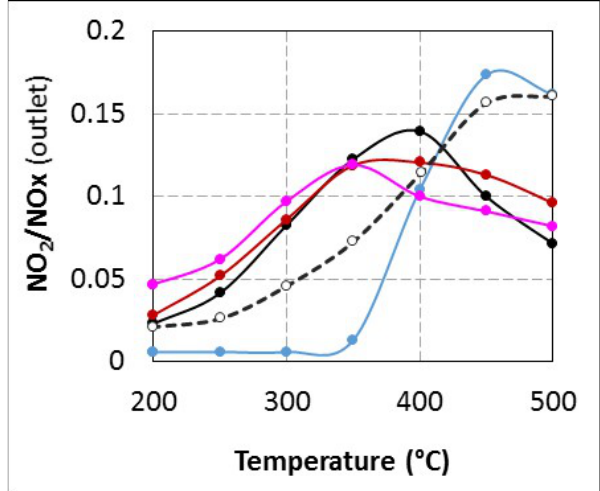
Figure 3. NO 2 /NO x outlet ratio versus temperature for: (▬): NH 3 -SCR; (▬): Urea SCR ( t R = 4.0 s); (▬): Urea SCR ( t R = 5.2 s); (▬): Urea SCR ( t R = 6.1 s); (---): activity of the catalyst in NO oxidation (400 ppm NO, 10% O 2 , 8% H 2 O, 10% CO 2